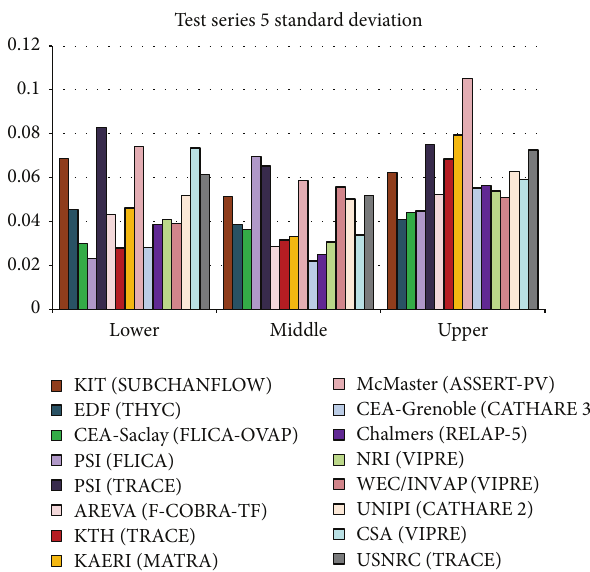
Figure 26: Test series 6 void fraction standard